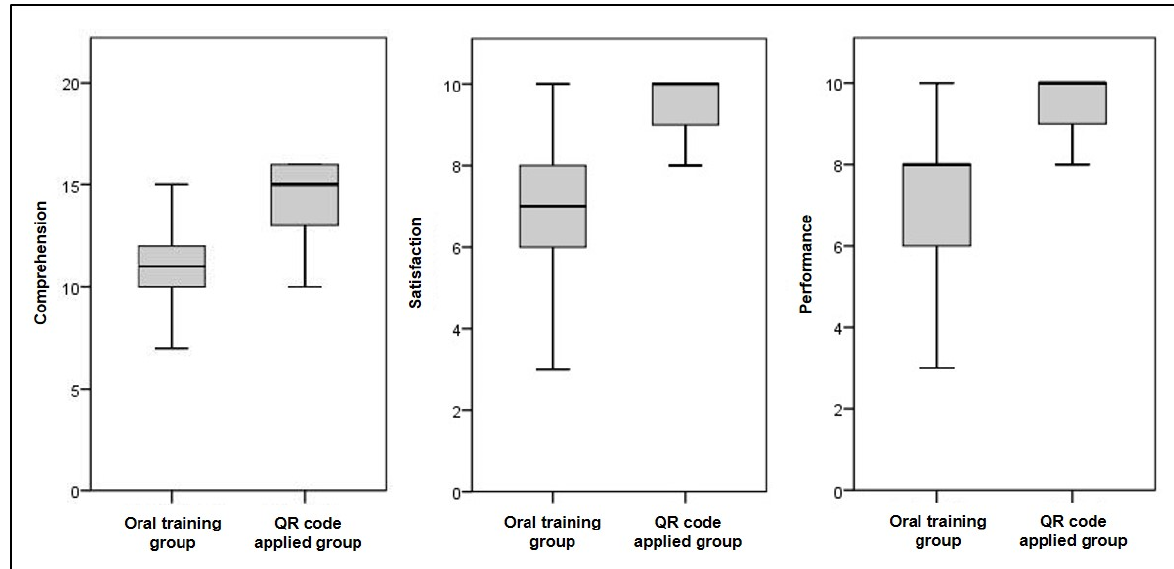
Figure 4. The mean scores of the four items measuring comprehension, satisfaction level, and performance score.